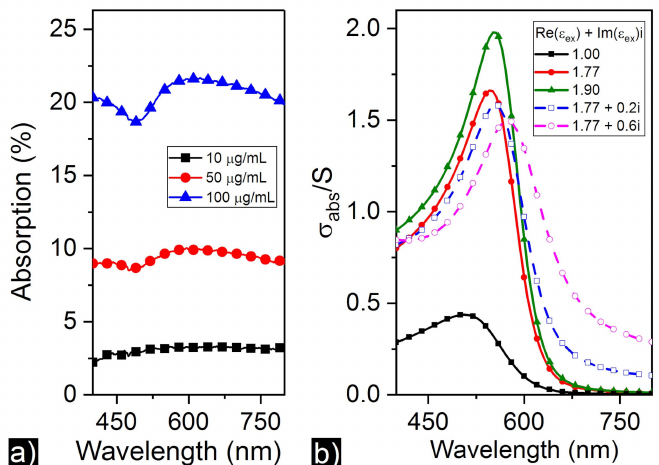
Figure 2. ( a ) Experimental absorption spectra for Au/CFO nanocomposite with different concen- trations; ( b ) Calculated extinction cross section with Equation (4) for gold spherical nanparticles of 10 nm in diameter in environment with different ε ex